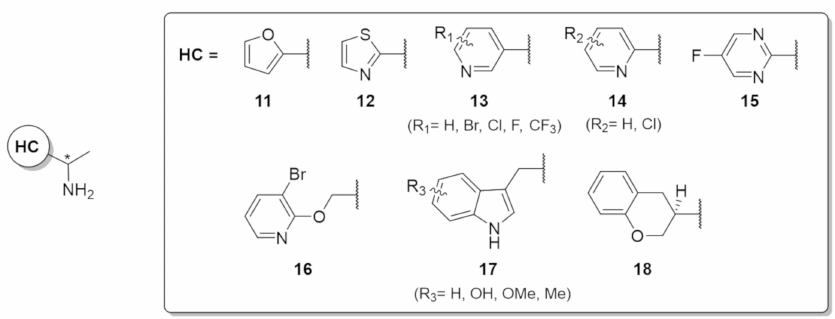
Figure 3. Heterocycles bearing asymmetric side chains with amine function by